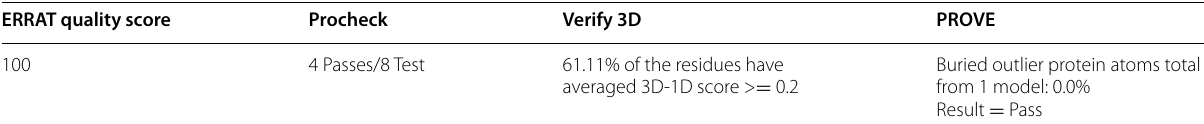
Table 4 Evaluation of model quality